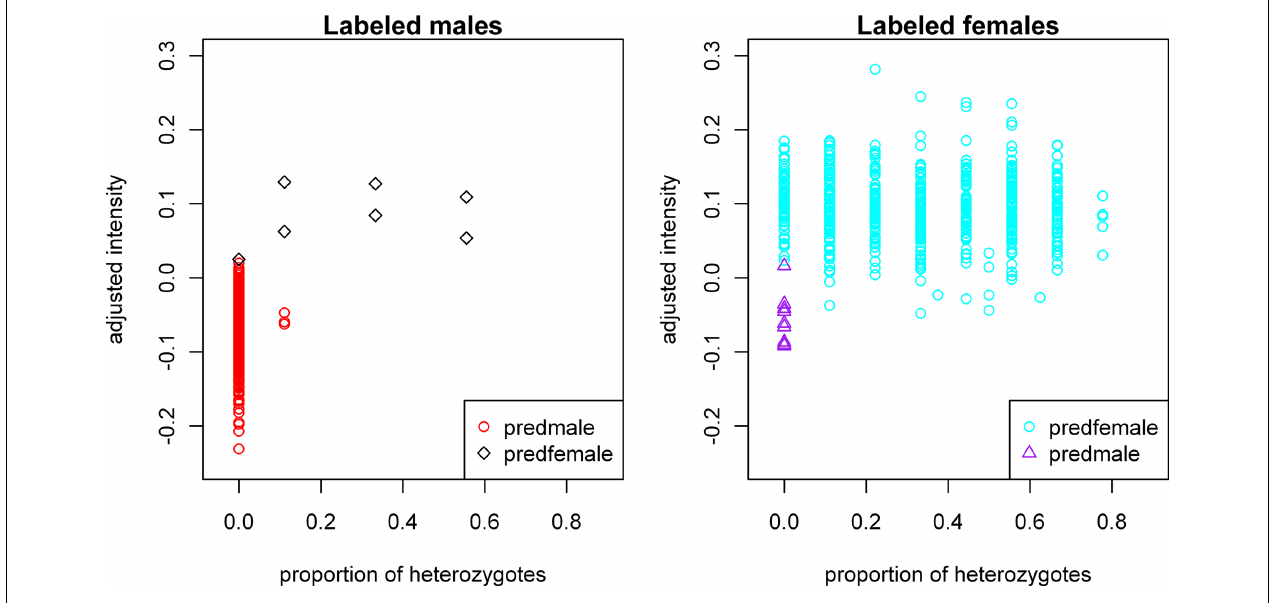
probability of being male greater than or equal to 0.5. X-chromosome intensity values on the vertical axes have been adjusted for the sample mean GenCall score and sample mean intensity across autosomal SNPs, as described in the